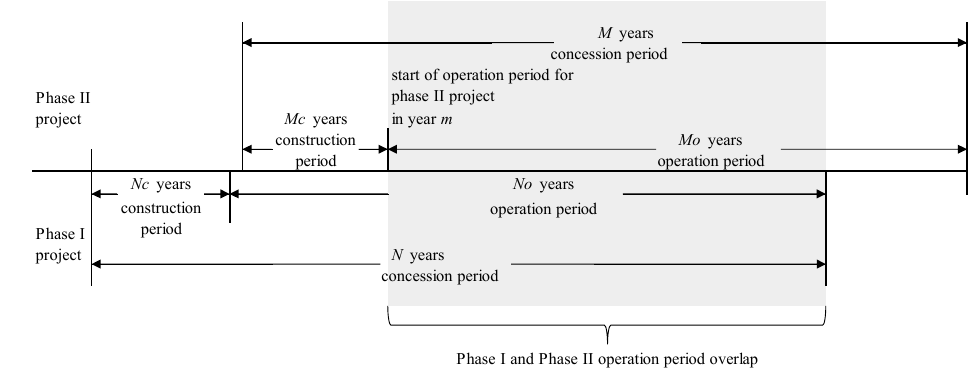
Figure 1. Concession periods of the phase I and phase II projects.